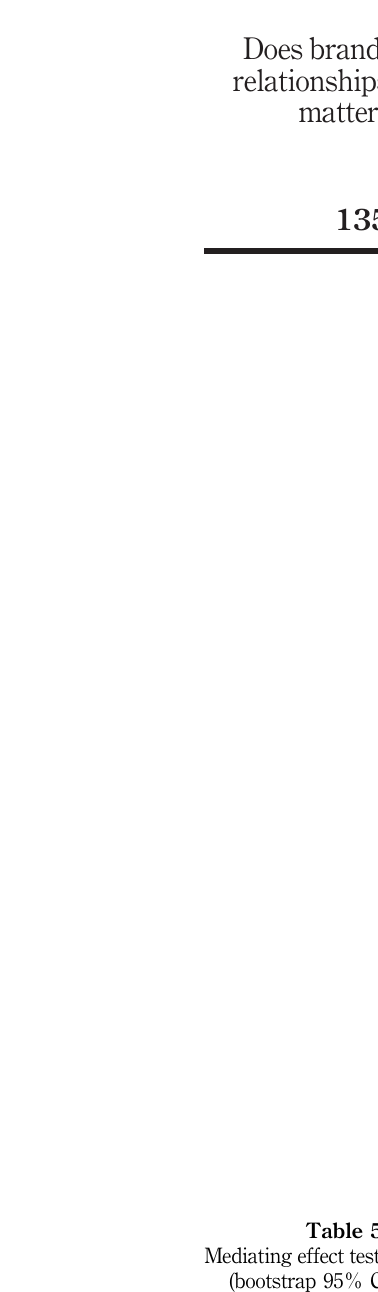
Table 5. Mediating effect